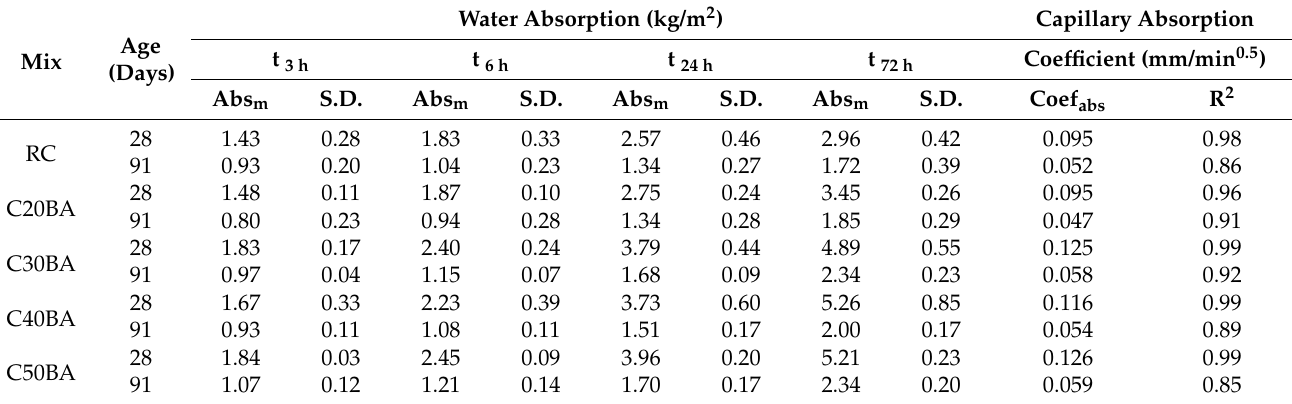
Table 8. Capillary water absorption results at 28 and 91 days.